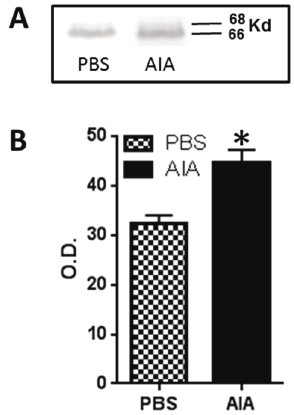
Figure 5. Western blot analysis of GLS from PBS- and CFA-injected rats at four days AIA. ( A ) Western blot of GLS from L4 DRG showed two bands, Mr 66,000 and Mr 68,000, corresponding to the two isoforms of GLS. There was an increase in GLS-ir in the 4 day AIA rats compared to PBS controls; ( B ) There was significant increase (38.1%) in the DRG from four day AIA rats compared to PBS-injected rats (* p < 0.05) (optical density (O.D.)—control: 32.34 ± 1.62; AIA: 44.67 ± 2.50).